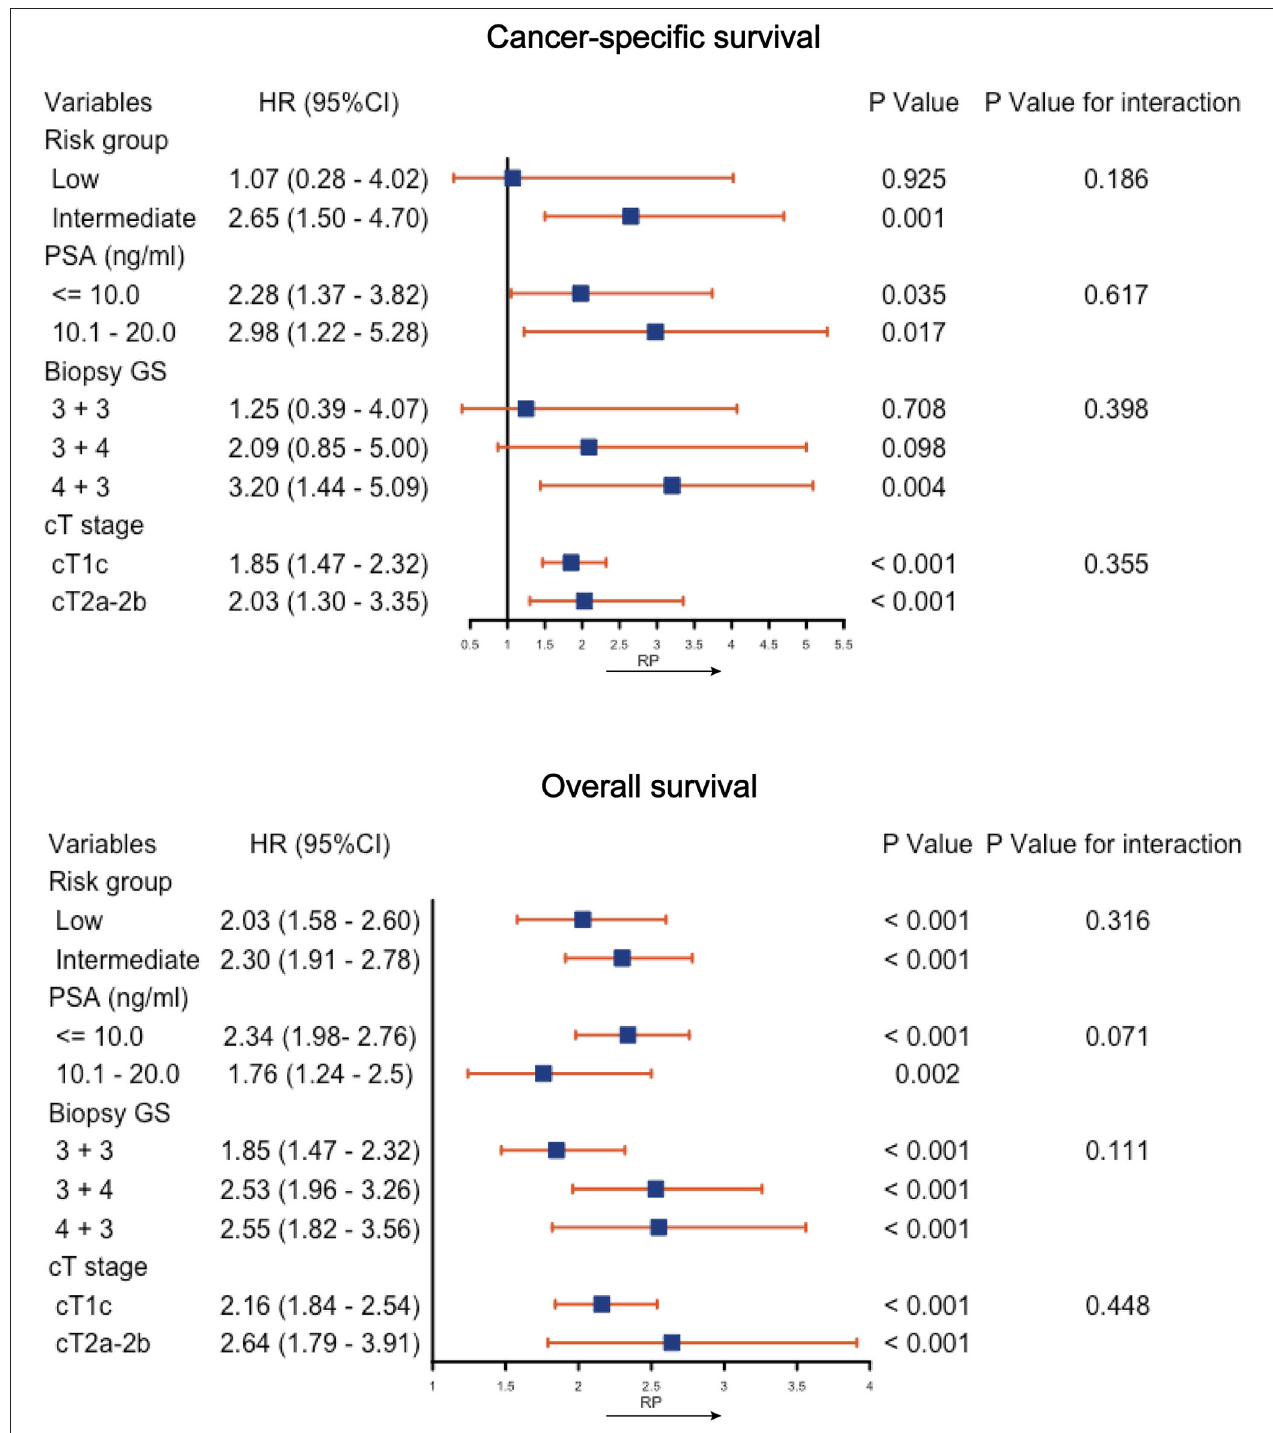
FIGURE 3 | Subgroup analysis of cancer-specific survival and overall survival by cryoablation vs. radical prostatectomy (RP). PSA, prostate specific antigen; GS, Gleason score; CI, confidence interval; HR, hazard ratio.